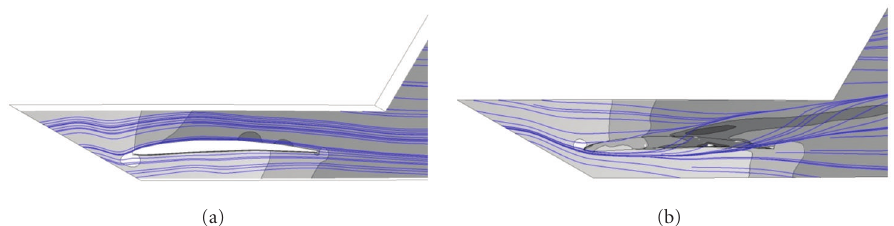
Figure 12: Pressure contours of surface located at (a) midway between blade tip and hub and (b) blade tip radios, for the case of 0.5 mm gap between the blade tip and casing surface.